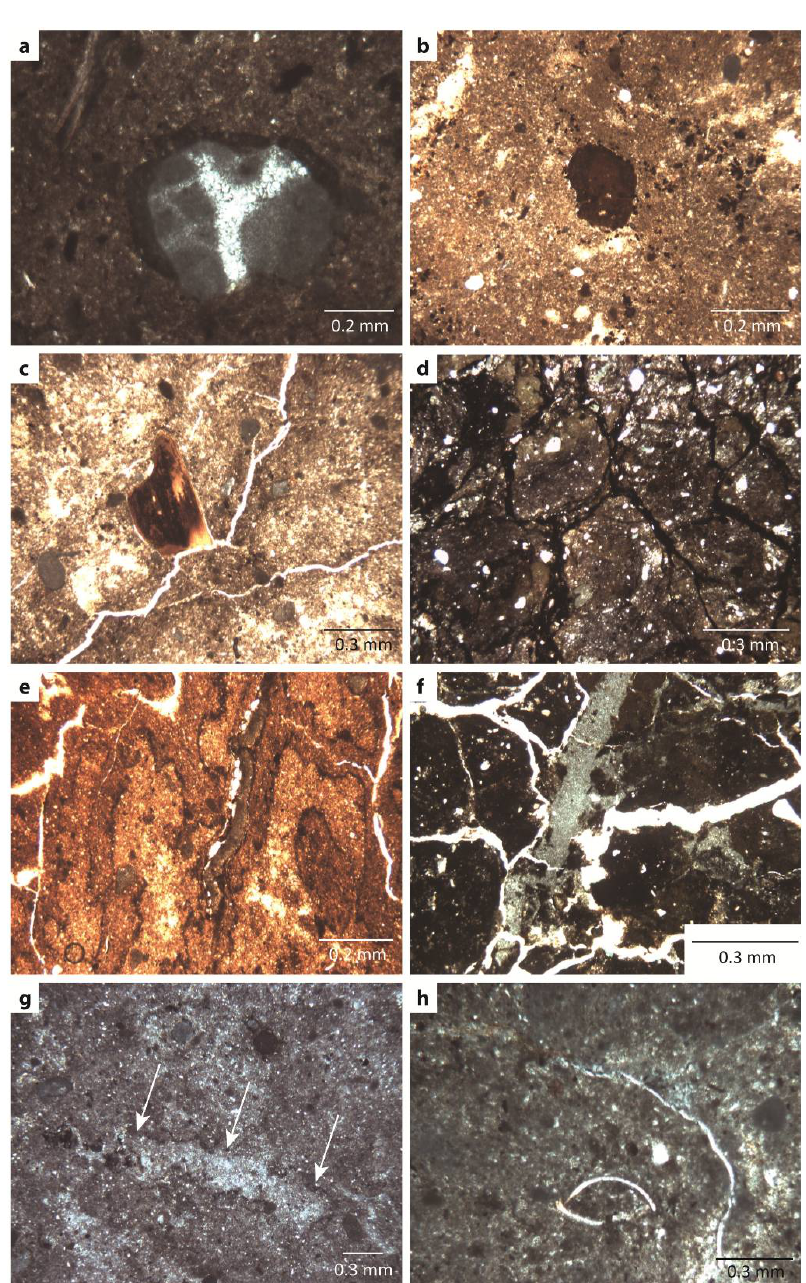
Figure 7. Paleosol features observed within thin section. ( a ) Calcite nodule within Unit 1 with a root trace secondarily filled with sparry calcite; ( b ) Rounded accumulation of illuviated clay within Unit 1; ( c ) Organic particle within the gleyed portion Unit 2; ( d ) Sub-angular to angular blocky peds of Unit 1 seen throughout both units; ( e ) Millimeter-scale fractures lined with illuviated clay within Unit 1. One fracture (at arrow) formed around a root trace and later filled in with sparry calcite; ( f ) Example of mottles seen in Unit 1; ( g ) Clay-lined burrow found within Unit 2; (h) Complete ostracode found in the upper portion of Unit